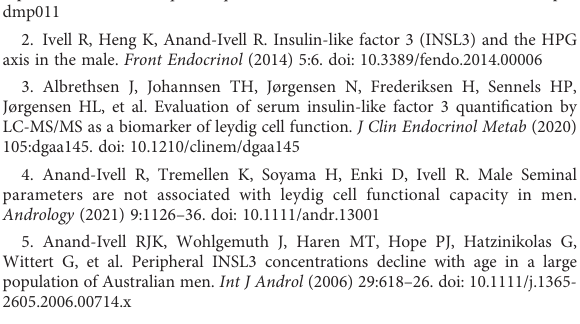
SUPPLEMENTARY TABLE 1 Descriptive statistics of relevant parameters measured for the available samples for phases 1 and 2 of the EMAS cohort. Data are expressed as means ± SD (number of subjects). SUPPLEMENTARY TABLE 2 Multiple regression analysis modelling the PASE (Physical Activity Scale for the Elderly) index, as well as BMD (bone mineral density), SOS (ultrasound speed of sound), and BUA (bone ultrasound attenuation) for heel bone ultrasound assessment as continuous dependent variables, using hormonal, anthropometric, and lifestyle parameters as independent variables, as indicated, including INSL3. std.b is the standardized beta coef fi cient for the model with its t value and signi fi cance (p value). excl. indicates a parameter excluded in the fi nal optimal model. This analysis is essentially similar to that in Table 1, except that cFT now replaces T and SHBG as informative